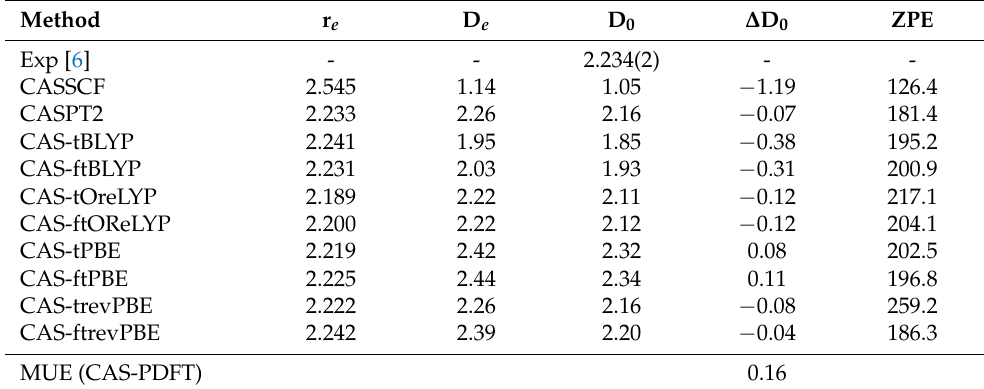
Table 6. Dissociation energies (eV), equilibrium bond lengths (Å), and zero point energies (in cm − 1 ) for VSi in the 2 ∆ molecular state, computed with a CASSCF wave function.